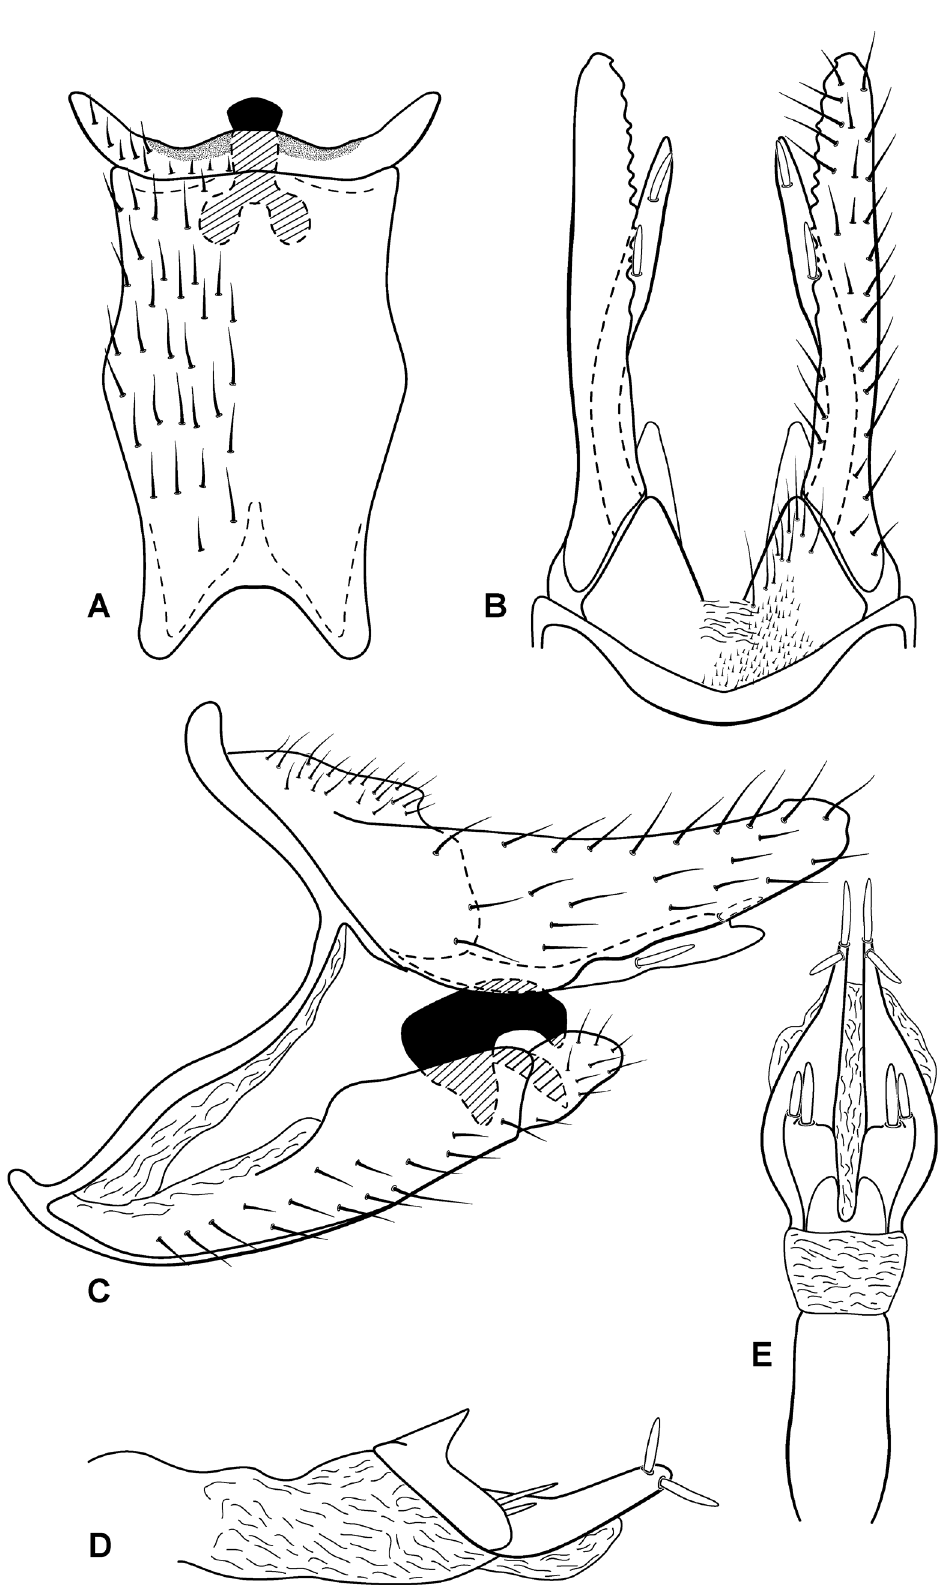
Fig. 11. Austrotinodes santosdumonti sp. nov., male genitalia. A . Ventral view. B . Dorsal view. C . Left lateral view. D . Phallic apparatus, left lateral view. E . Phallic apparatus, dorsal